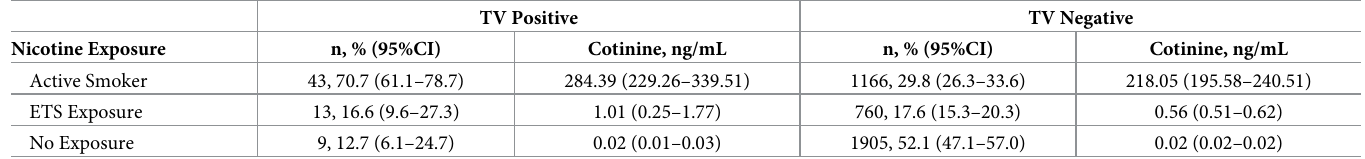
Table 2. Infection status by nicotine